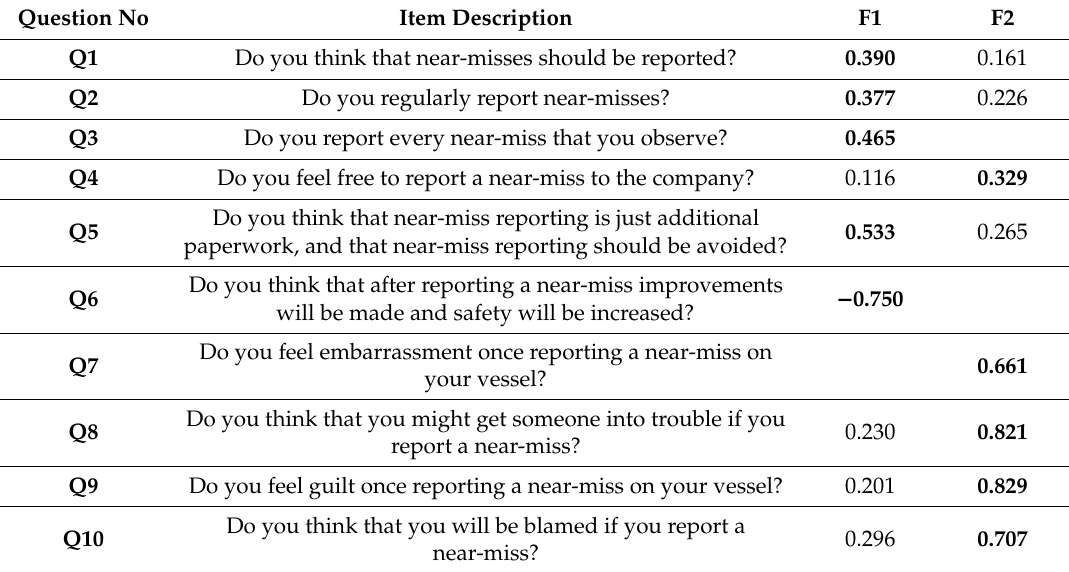
Table 4. Two extracted factors with loadings.